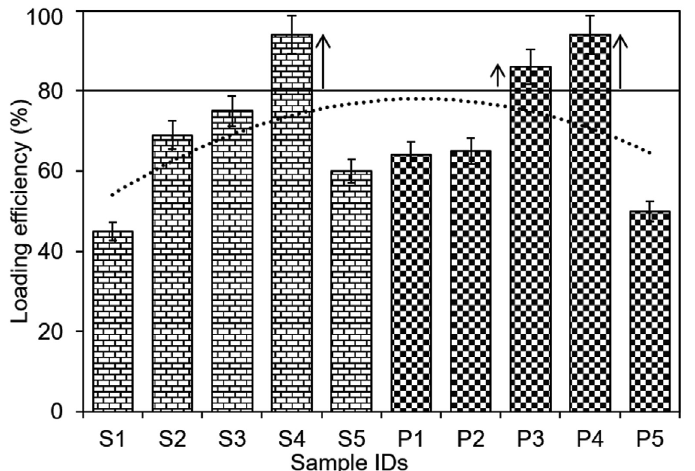
Fig. 4. Percent loading efficiency of newly in-house engineered silver and platinum nanoparticles into/onto chitosan- based bio-composites.